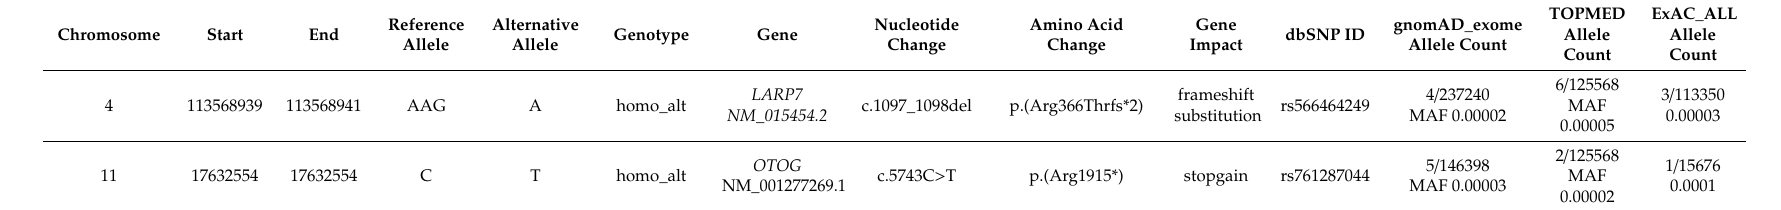
Table 2. Characteristics of the variants identified in the LARP7 and OTOG